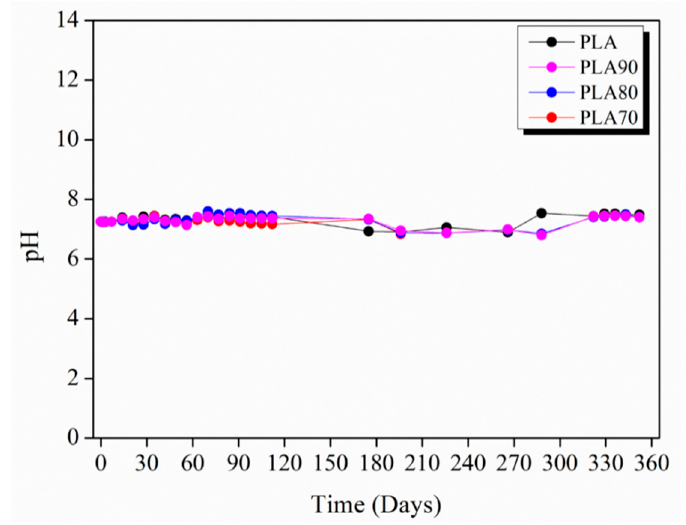
Figure 11. pH values measured weekly for neat PLA and each of the PLA:OLA electrospun samples up to 352 days of immersion in PBS.